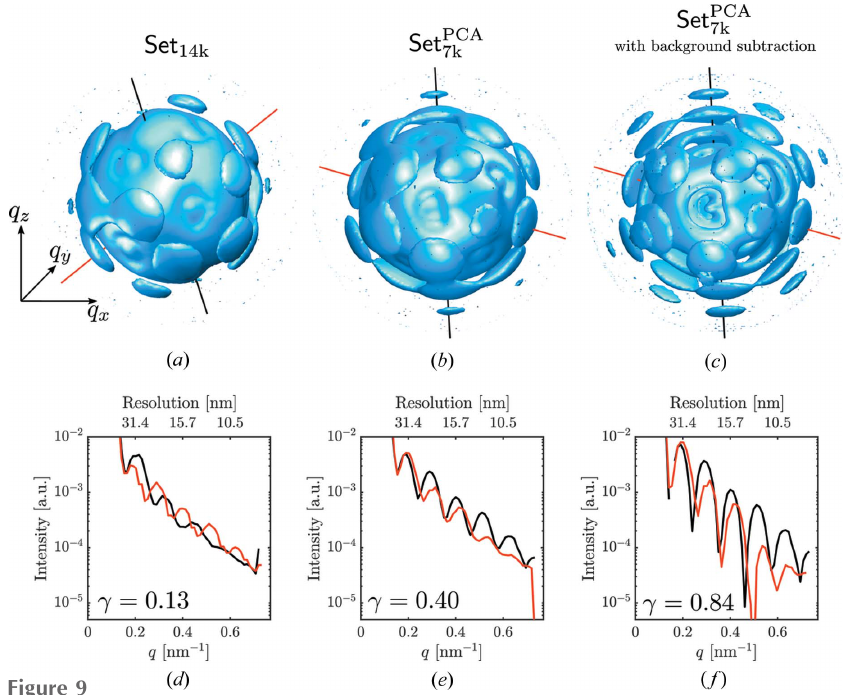
Figure 9 ( a )–( c ) Three-dimensional intensity distribution from data Set 14k ( a ), data Set 7kPCA ( b ), and data Set 7kPCA ( c ) with background subtraction. All three intensity distributions are shown in a logarithmic scale in different orientations. ( d )–( f ) Line profiles along the red and black lines shown in ( a )–( c ) for three data sets. Note that the data sets in ( a ) and ( b ) are not aligned because of the non-deterministic iterative orientation